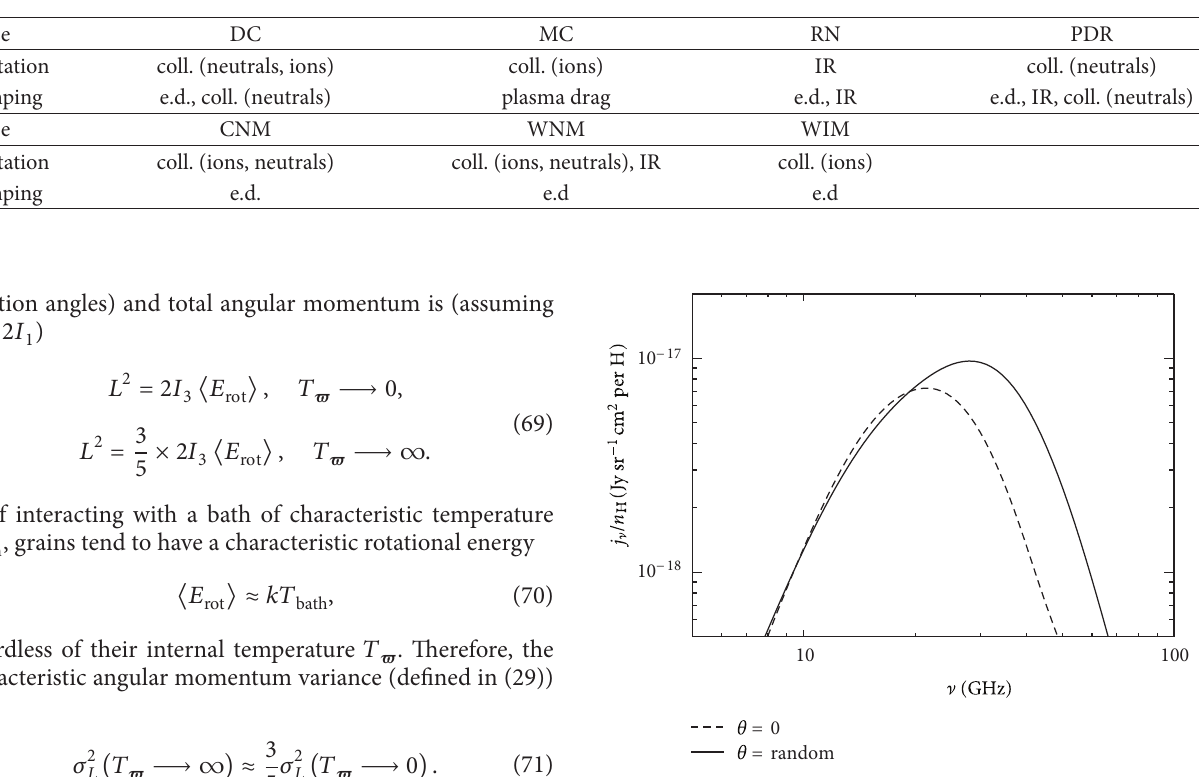
T1:Dominantexcitationanddampingmechanismsforthesmallestgrainsconsidered( Å),asafunctionofidealizedenvironment